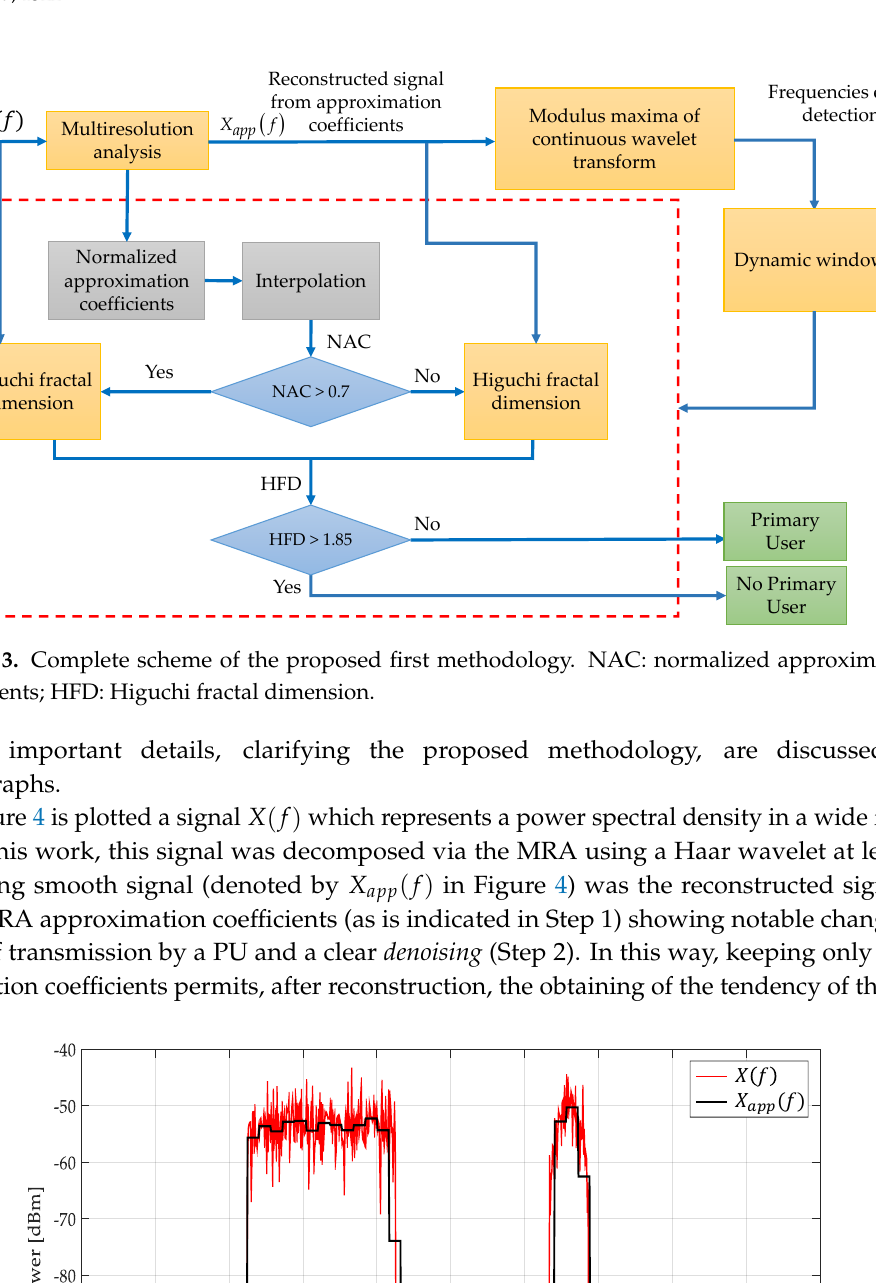
Figure 4. The result of applying MRA to